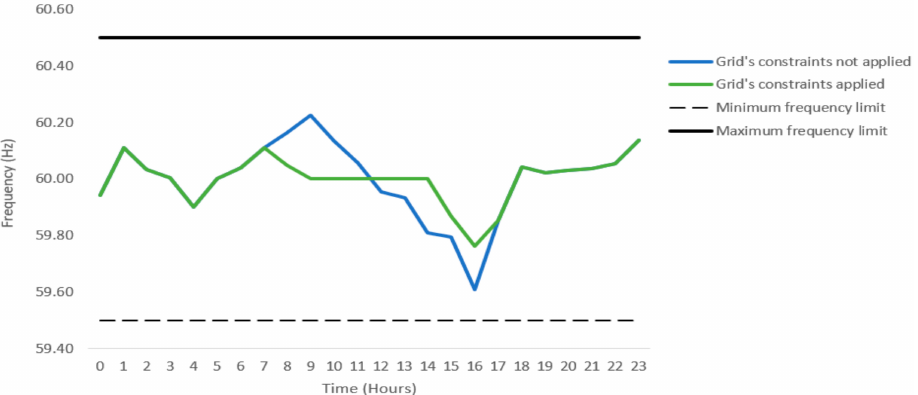
Figure 17. Grid constraints effect on the grid frequency representation of the January load of Riyadh, 2017, with the inclusion of the PV system at 50%